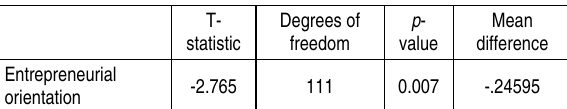
Table 3. Hypothesis testing one –